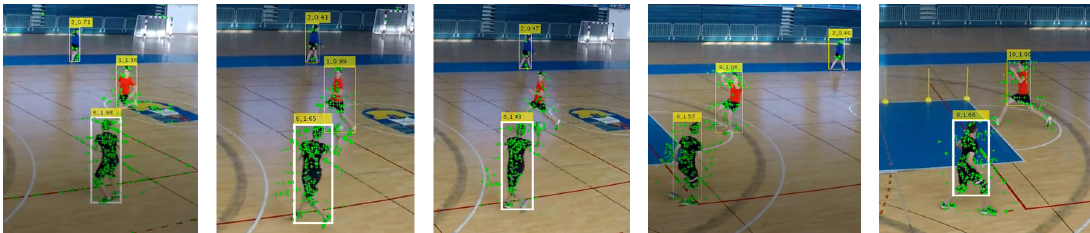
Figure 7. Indicating the most active player on each frame (marked with thick white bounding box).